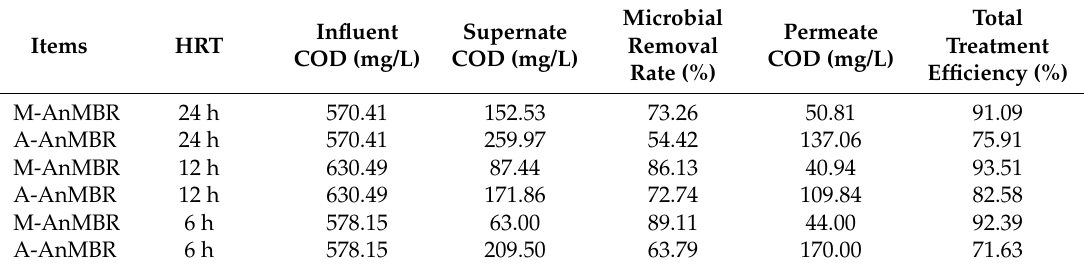
Table 1. Wastewater treatment efficiencies of the anaerobic membrane bioreactors under mesophilic temperature (M-AnMBR) and atmospheric temperature (A-AnMBR) with different hydraulic retention times